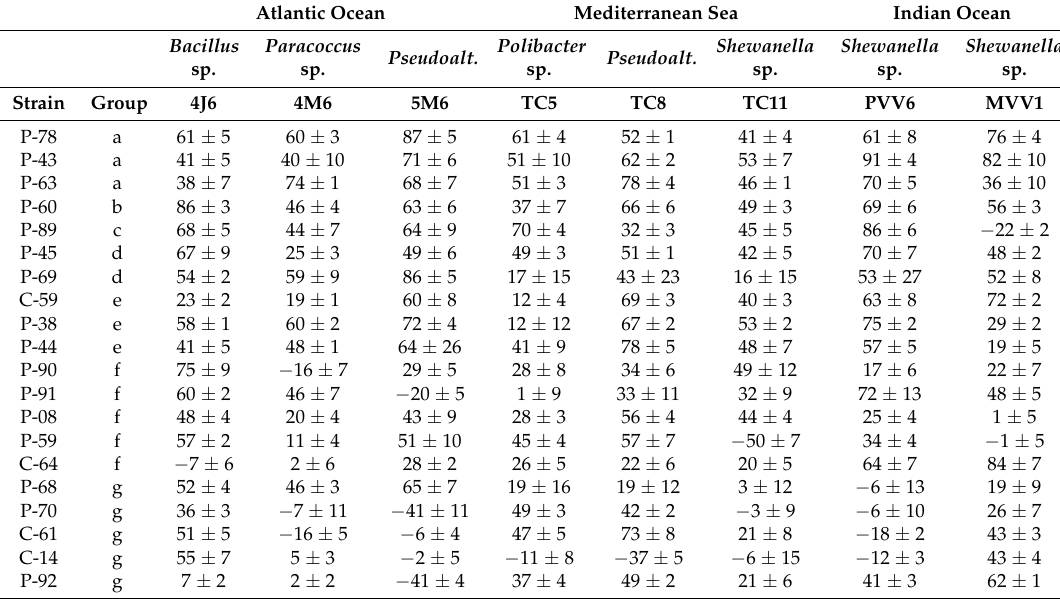
Table 2. Inhibition of bacterial adhesion (%) in the presence of tropical microalgal extracts (50 µ g mL − 1 ). Atlantic Ocean Mediterranean Sea Indian Ocean Bacillus Paracoccus Polibacter Shewanella Shewanella Pseudoalt. Pseudoalt. sp. sp. sp. sp.